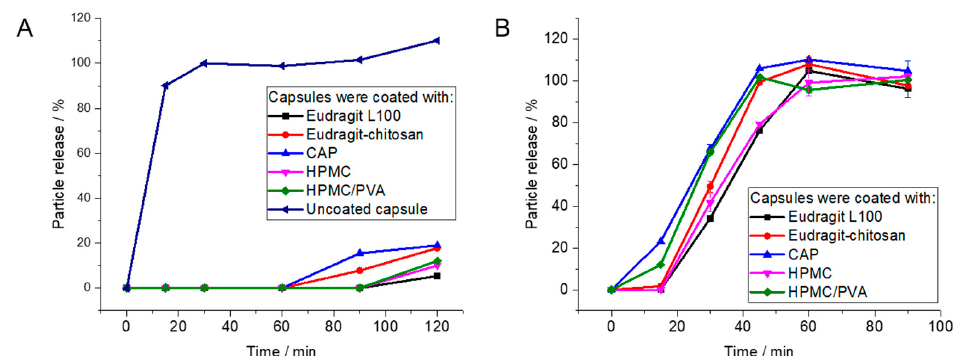
Figure 7. Release of Au-BSA nanoclusters from polymer-coated capsules by atomic absorption spectroscopy (AAS): ( A ): Coated capsules are stable under simulated stomach conditions (pH 1). ( B ): Capsules dissolve under simulated intestinal conditions (pH 7.1).